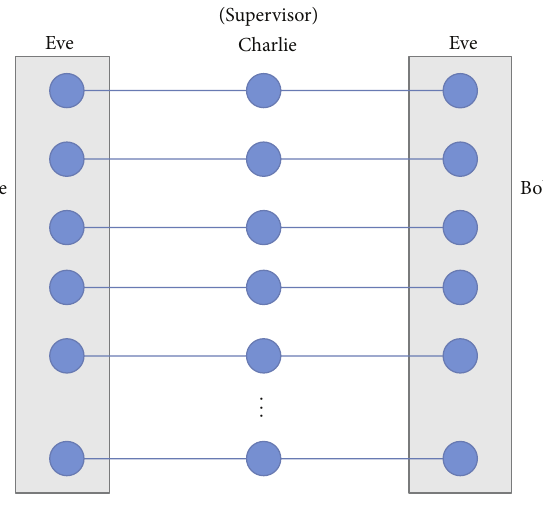
Figure 5: The scenario of Eve intercepts